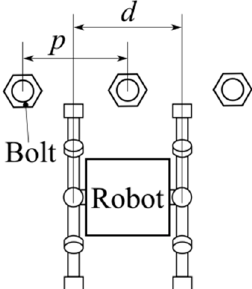
Figure 2. Bolt pitch of splice part. The length d is the wheel track of the robot and the length p is the interval of the bolts.